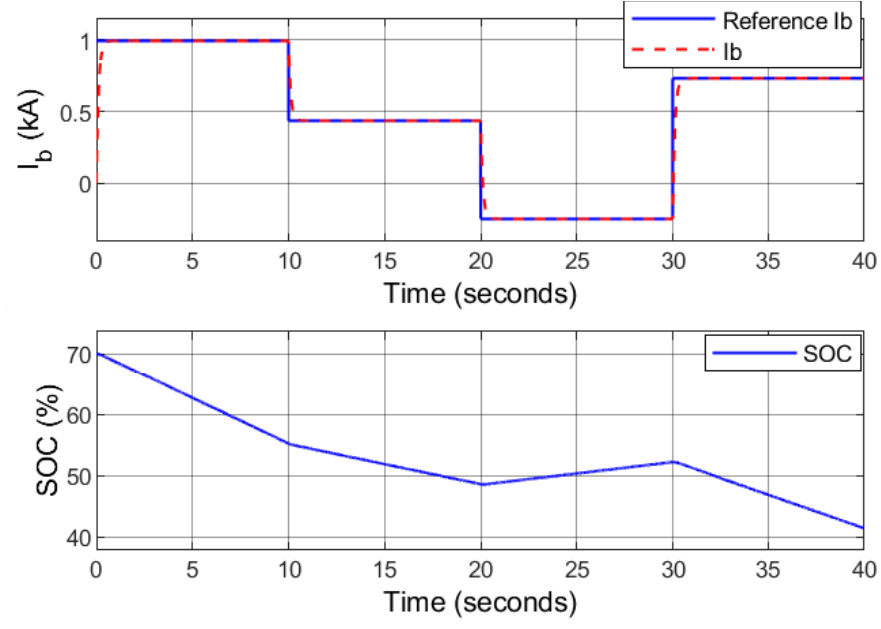
Figure 9. Scenario 2: tracking performance of the battery current and the corresponding